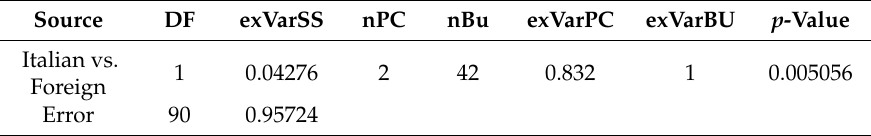
Table 1. MANOVA results based on Italian and foreign EVOO samples.